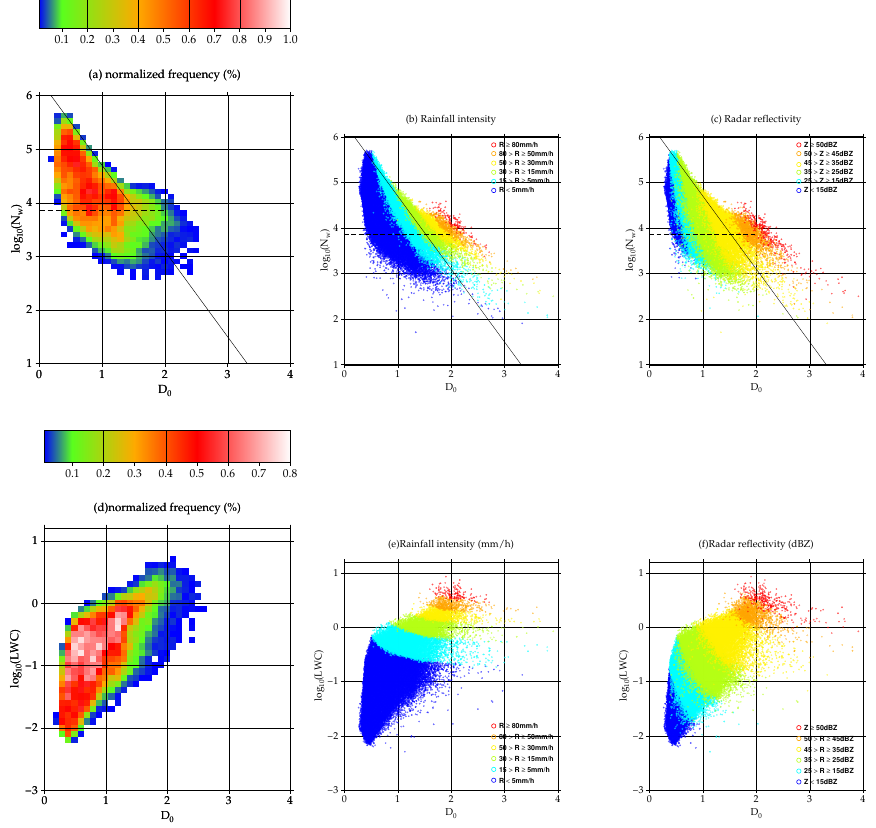
Figure 5. ( a )–( c ) D 0 − log 10 N w and ( d )–( f ) D 0 − log 10 LWC diagrams. ( a , d ) The number density (%), ( b , e ) the distribution of six categories of rain rates, and ( c , f ) the distribution of the six categories of radar reflectivities are shown. Solid and dashed lines in ( a )–( c ) are the stratiform/convective separation lines proposed by Bringi et al. [54] and Thompson et al. [55],